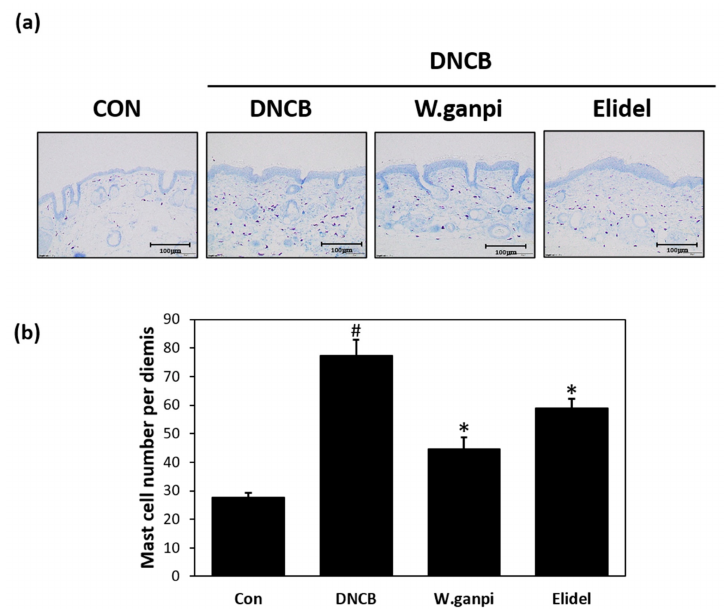
Figure 3. Effects of WGE on the change of the number of mast cells per dermis in AD-like symptoms induced by DNCB in hairless mice. ( a ) Results of changes in the number of the mast cells per dermis of skin lesion determined by histopathological examination. Stained by toluidine blue; ( b ) The number of mast cells per dermis. CON: control group, DNCB: DNCB-treated group, W. ganpi : DNCB and 1% W. ganpi EtOH extract-treated group, Elidel: DNCB and Elidel treated group. # p < 0.05 vs. the CON group; * p < 0.05 vs. the DNCB